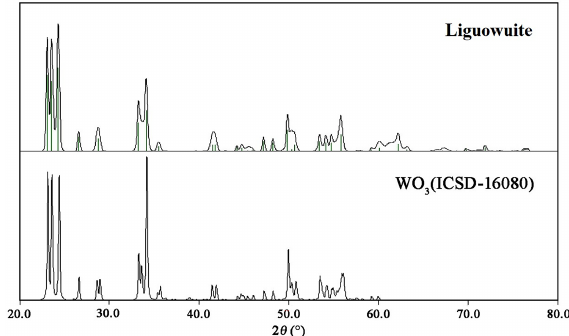
Table 1. Chemical data (wt%) for liguowuite.